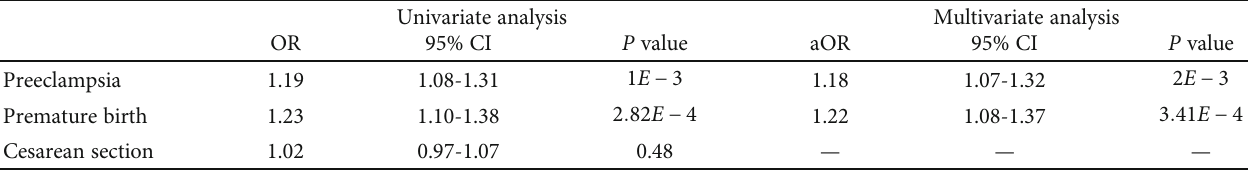
Table 5: Logistic analysis of total bile acid and adverse pregnancy outcomes in women without